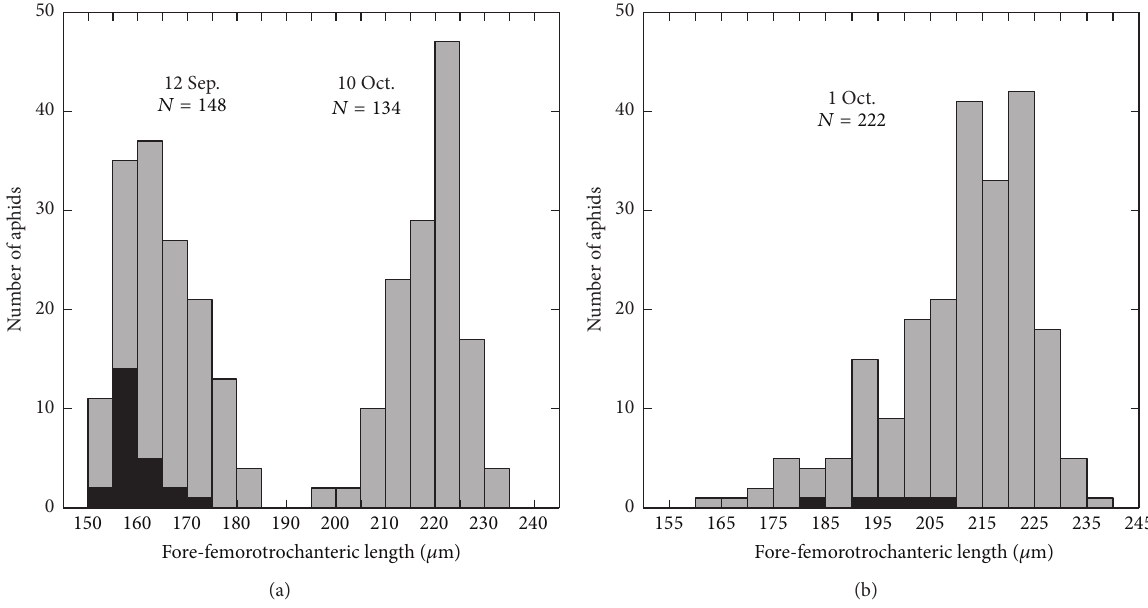
Figure 8: Frequency distribution of the fore-femorotrochanteric length of first-instar nymphs to be alates with (indicated by black) or without (indicated by grey) the next-instar cuticle developing inside. (a) Colony 15228 (left) on 12 September 2015 and colony 14160 (right) on 10 October 2014; (b) colony Exp#7 on 1 October 2015.